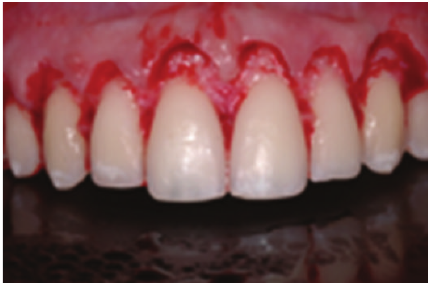
Figure 10: Flap elevation displays the condition.